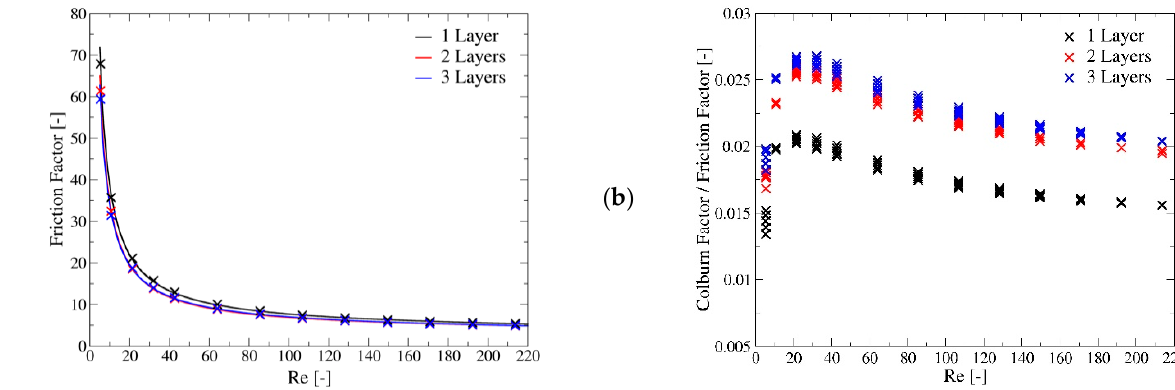
Figure 8. ( a ) Friction factor dependence of the Reynolds number for the investigate geometries. ( b ) Ratio of the Colburn Factor on the friction factor as function of the Reynolds number for the investigate geometries. The cross marks are the results of CFD computation, while the continuous lines are the regression curve given by Equation (17).